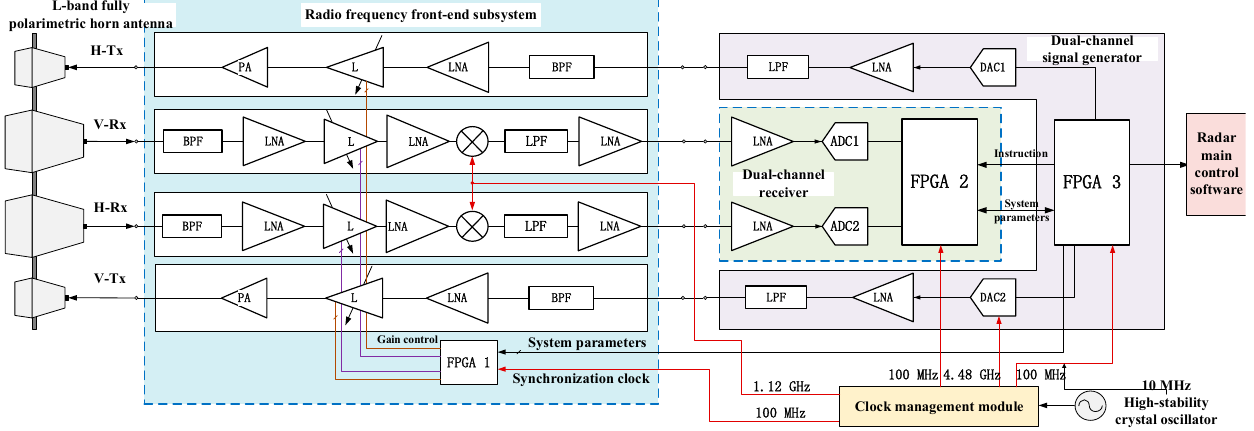
Figure 1. Block diagram of L-band fully polarimetric radar system. Two pairs of horn antennas are designed for the transmission and reception of L-band fully polarimetric signals. The gain of the transmitting antenna is 10.5 dB, the gain of the receiving antenna is 15.5 dB, and the polarization isolation is better than 31